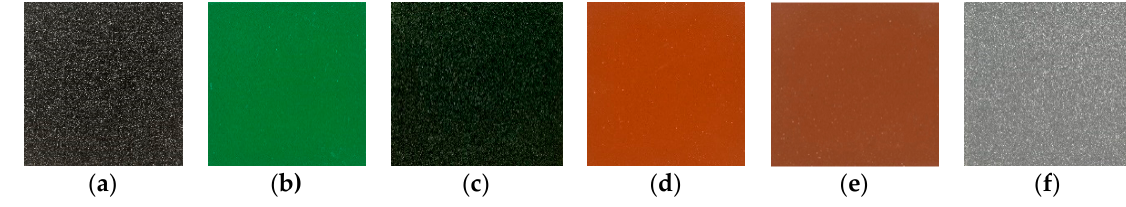
Figure 2. Tested coatings: ( a ) TFI-76521 (perfluoroalkoxy (PFA)); ( b ) TF-531 (fluorinated ethylene propylene (FEP)); ( c ) TFI-851E (polytetrafluoroethylene (PTFE)); ( d ) TS-RTV1 (silicone rubber); ( e ) RTV1 + Ce (silicone rubber +cerium); and ( f ) TFC-51N (sol-gel. Ceramic).